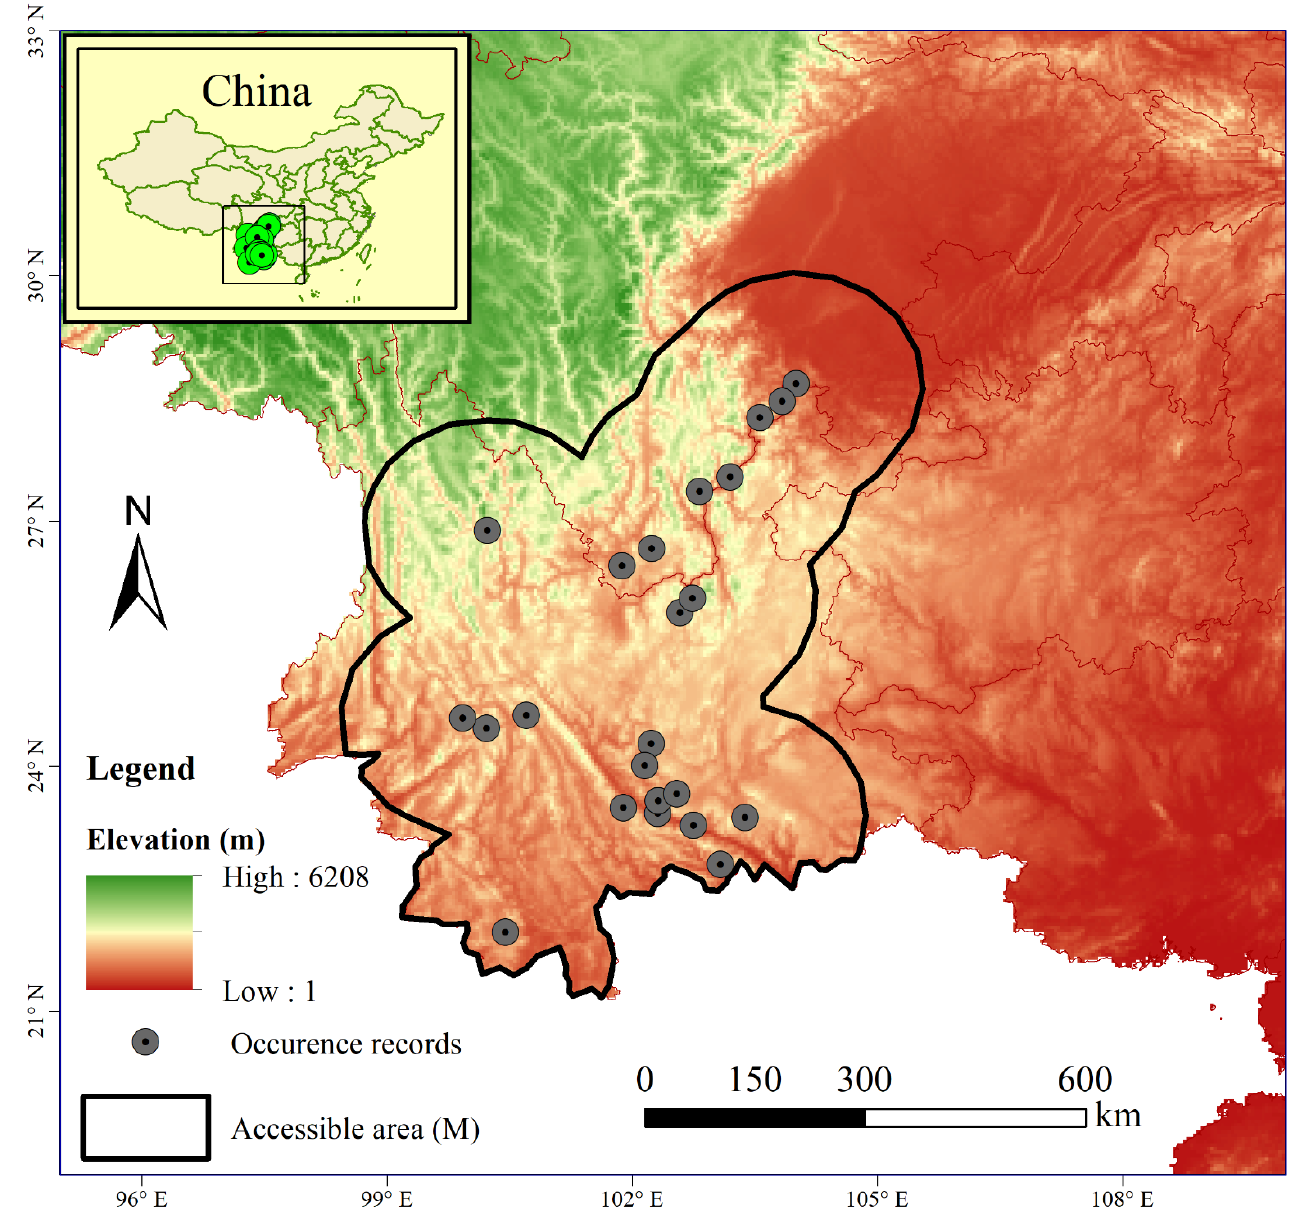
Figure 2. Map showing the current occurrence records and elevation of the study area and the areas accessible ( M ) to Garuga forrestii through natural